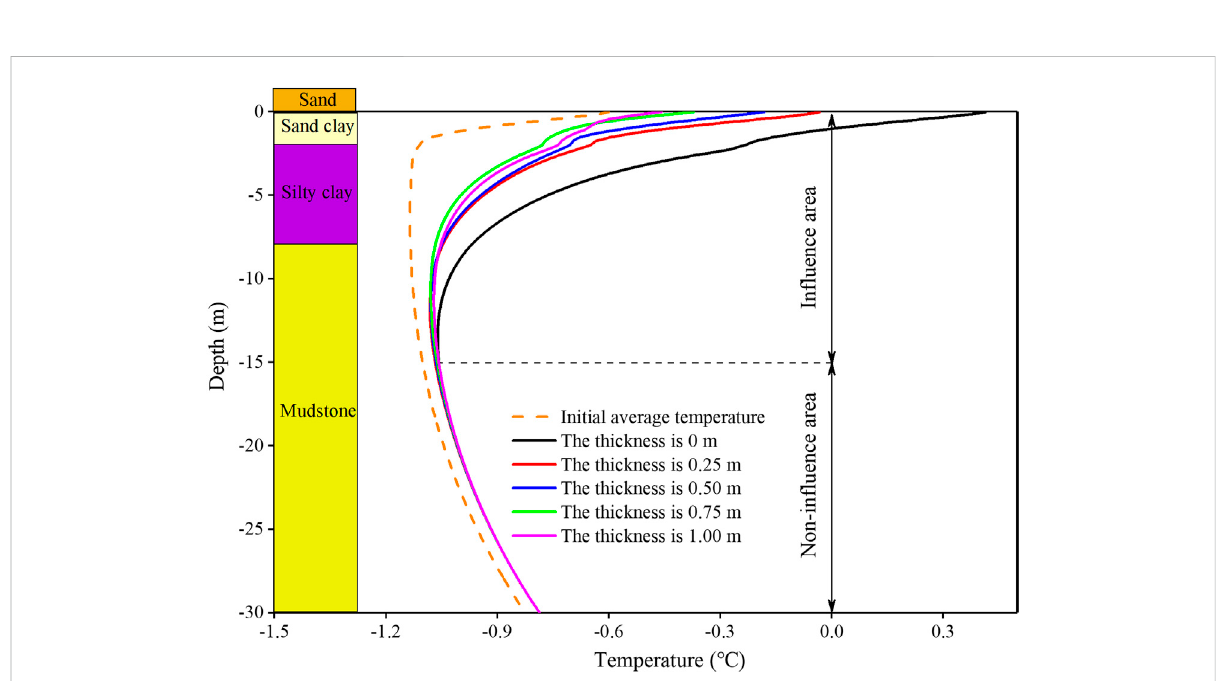
FIGURE 7 Average geotemperature of stratum covered by sand layer with different thickness in the 20th